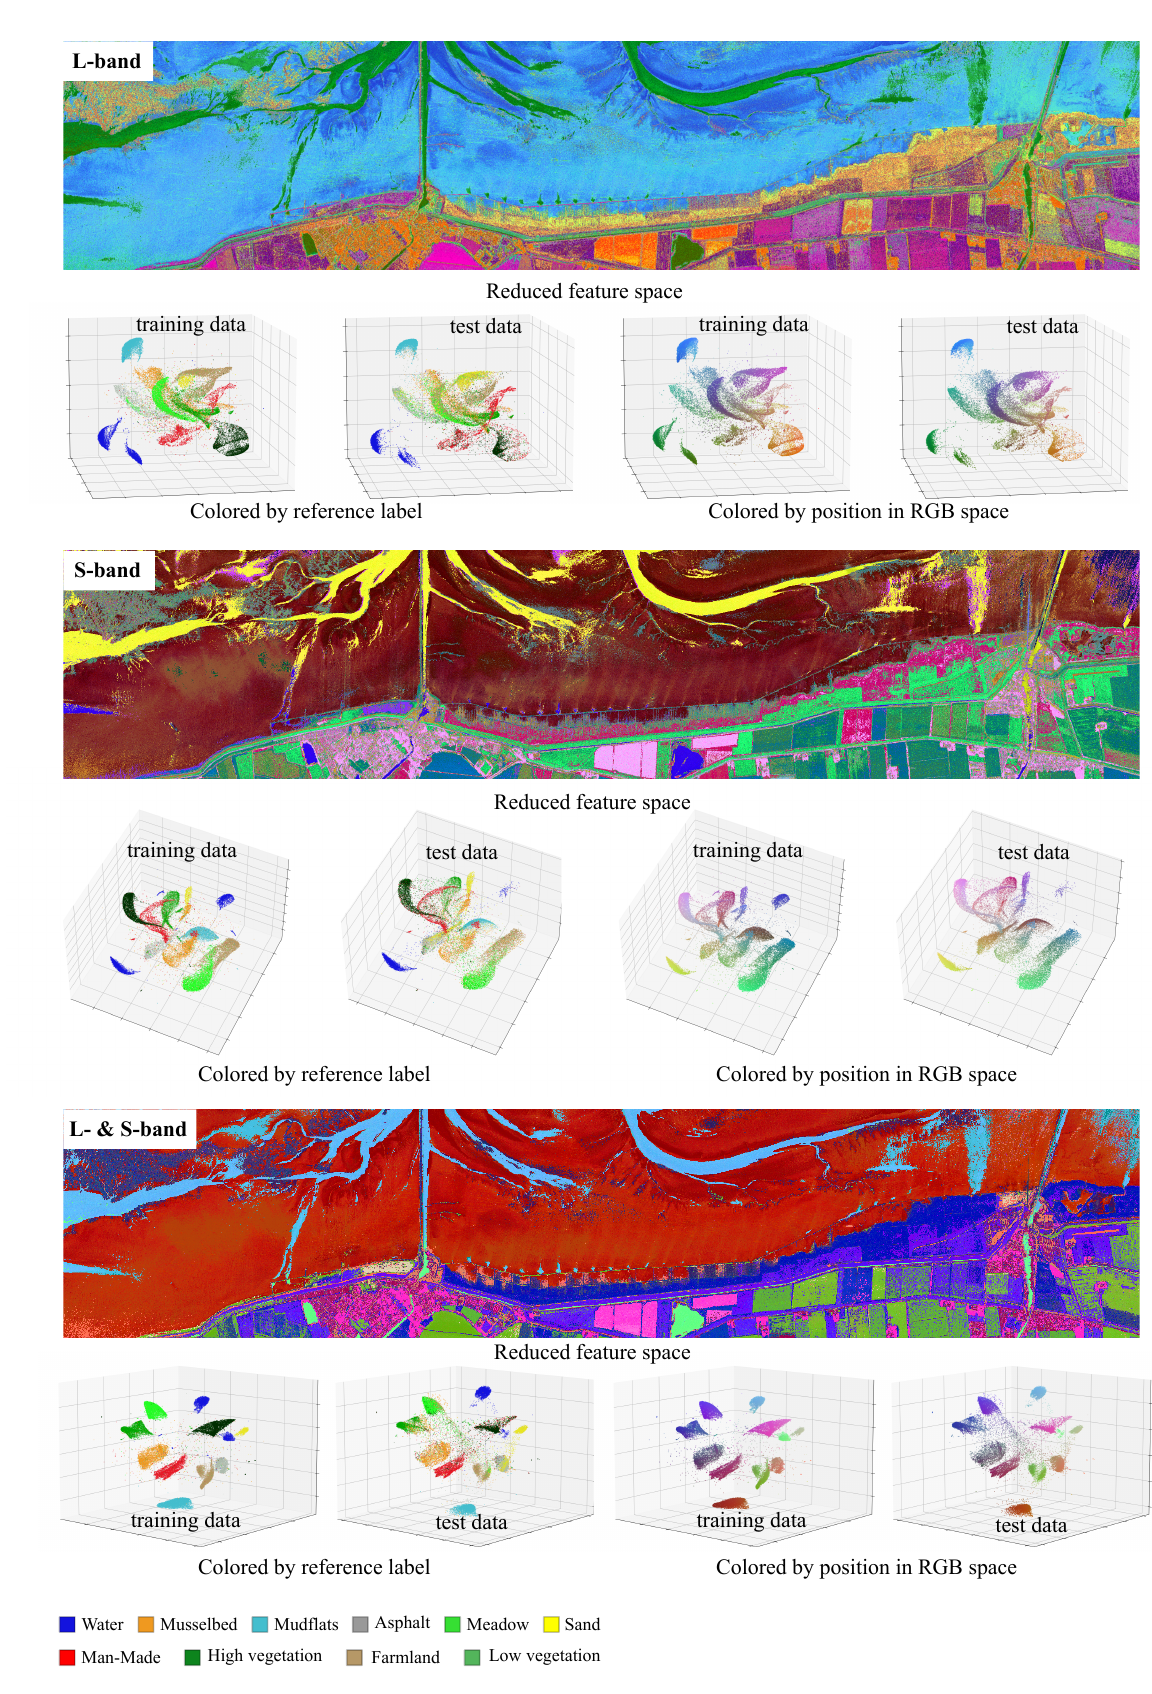
Figure 3. RGB visualizations and scatterplots that show the reduced feature spaces resulting from supervised UMAP. Data points of training and test data are illustrated separately. From left to right: In the first and second scatterplot, data points are colored by their reference label. In the third and forth scatterplot, data points are colored according to their position in the feature